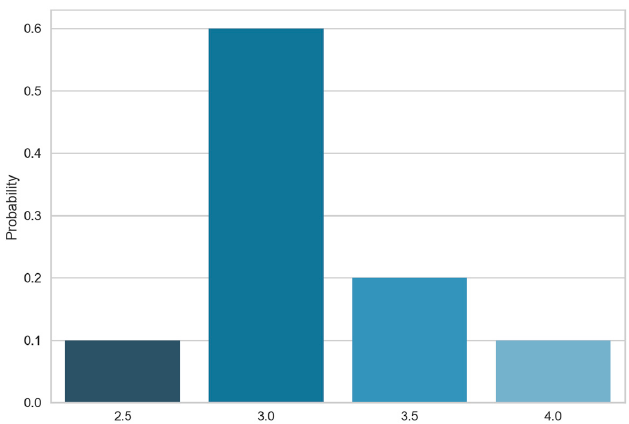
Figure 7. Probability density of the duration of stay of an EV at the ArenA.